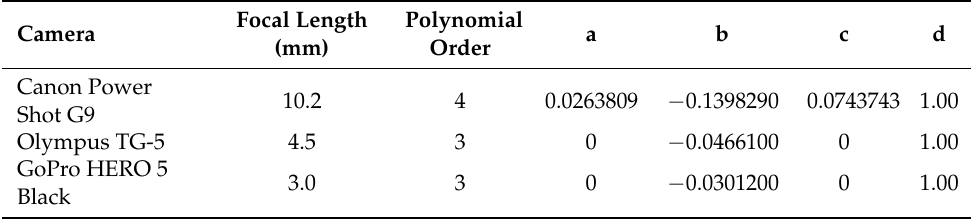
Table 3. Table of Distortion Parameters for Each Camera.